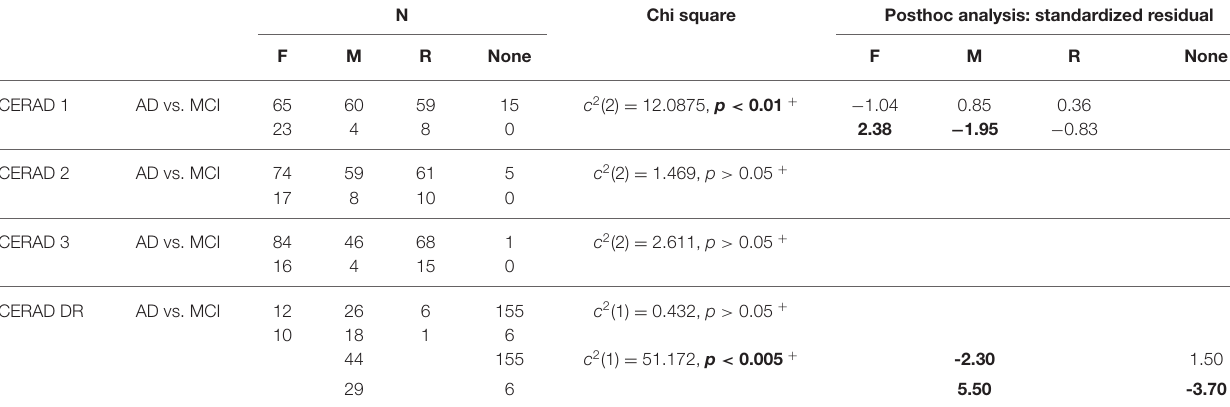
TABLE 3 | Primacy and recency effects, calculated using the first word recalled measure. N Chi square Posthoc analysis: standardized